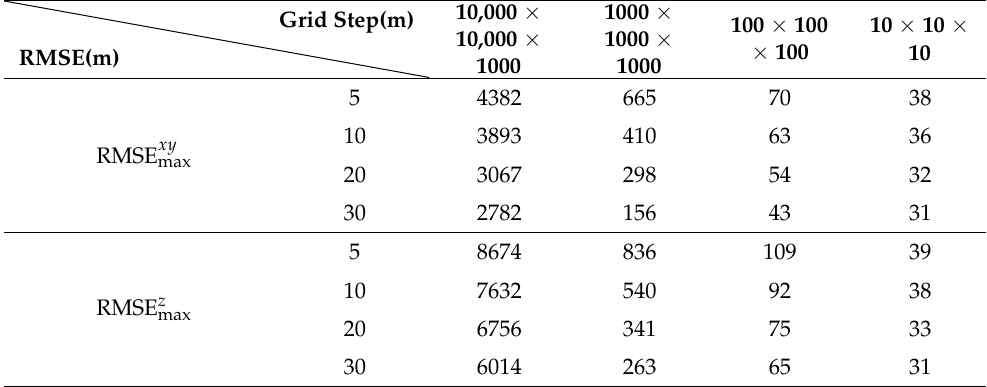
Table 1. Maximum RMSE under different grid step and number of receivers inside the receiver network.